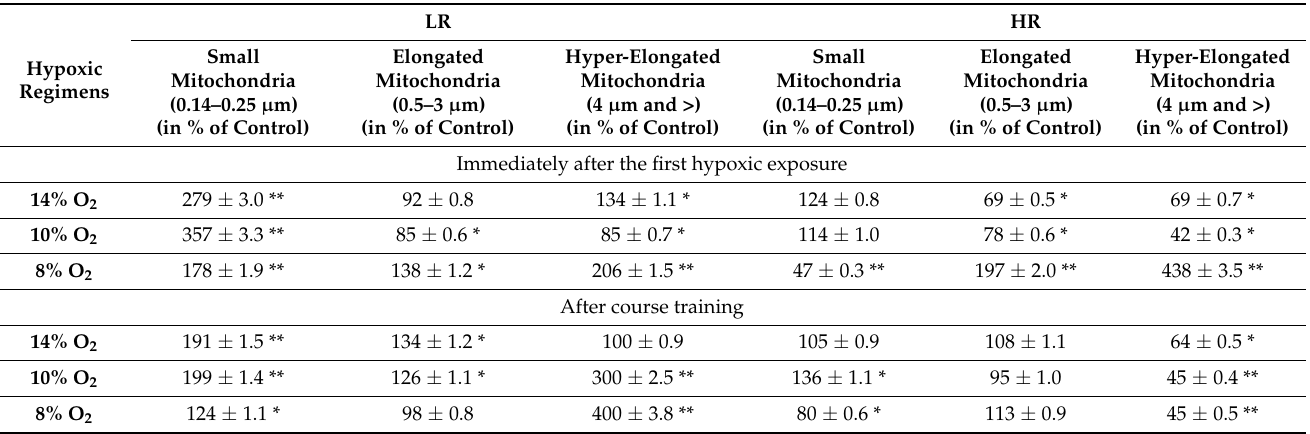
Table 4. Effects of different hypoxic regimens on the shape and size of CC mitochondria in LR and HR rats.